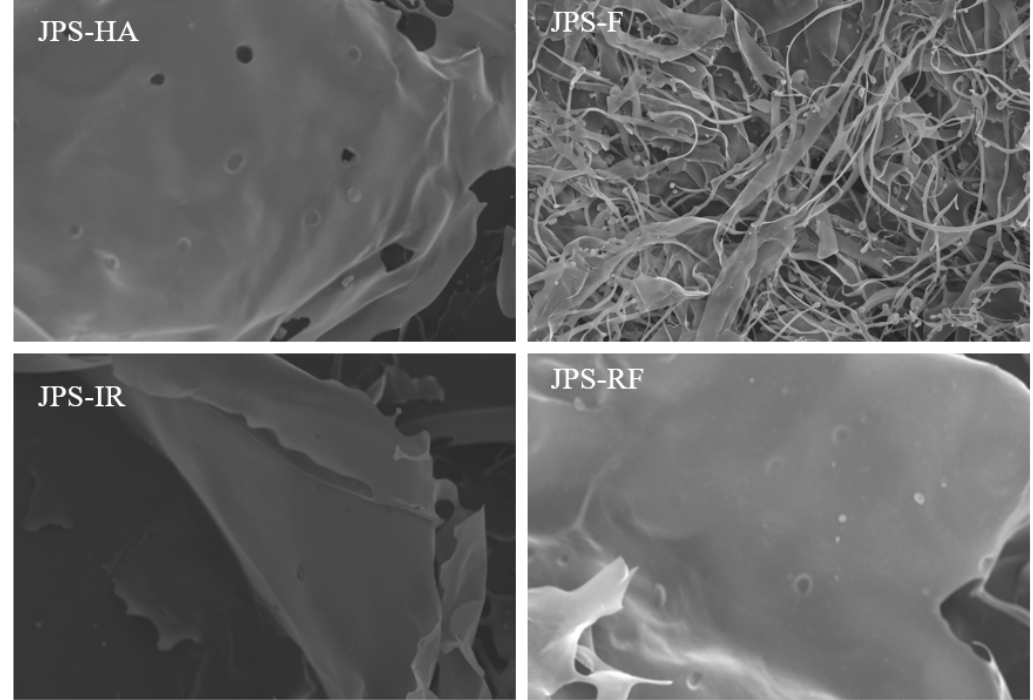
Figure 3. Scanning electron micrographs (500×) of four polysaccharides obtained from different drying methods.